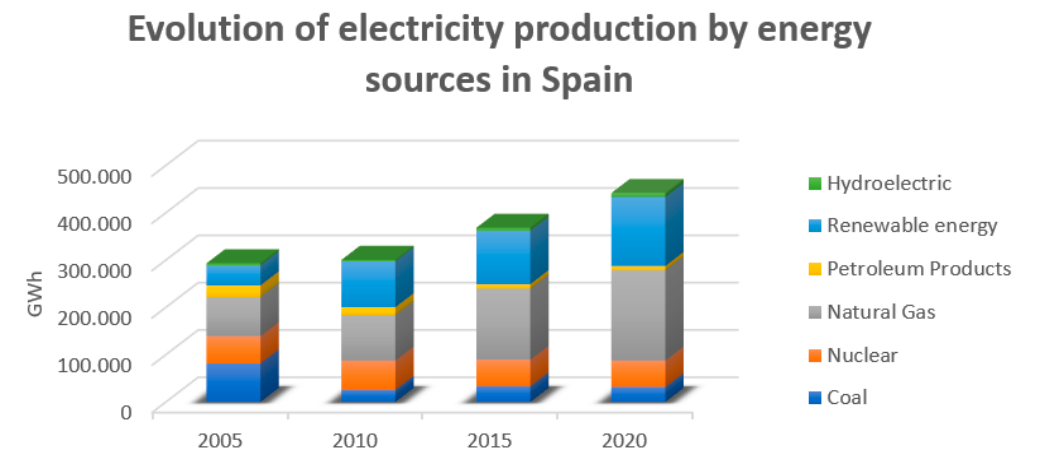
Figure 1. Evolution of electricity production by energy sources in